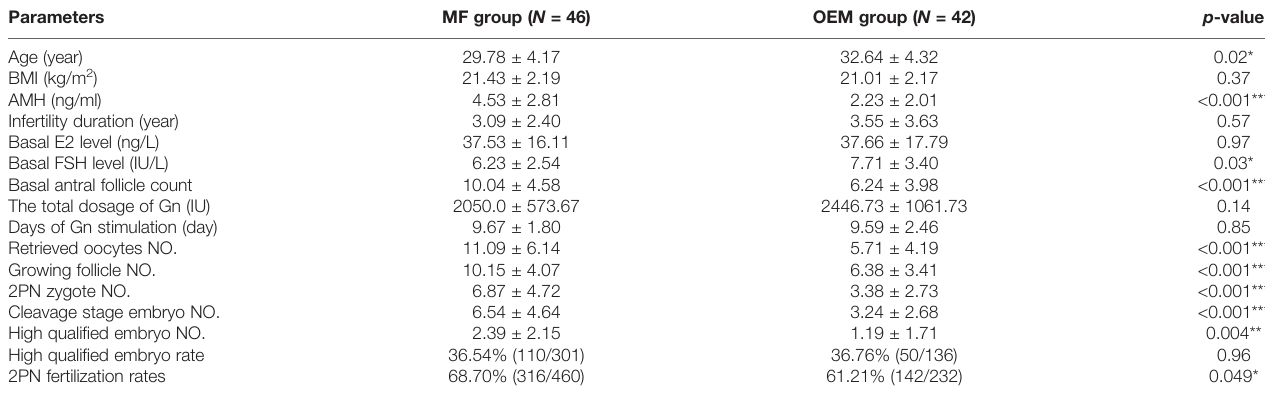
TABLE 2 | Clinical characteristics of infertile patients for